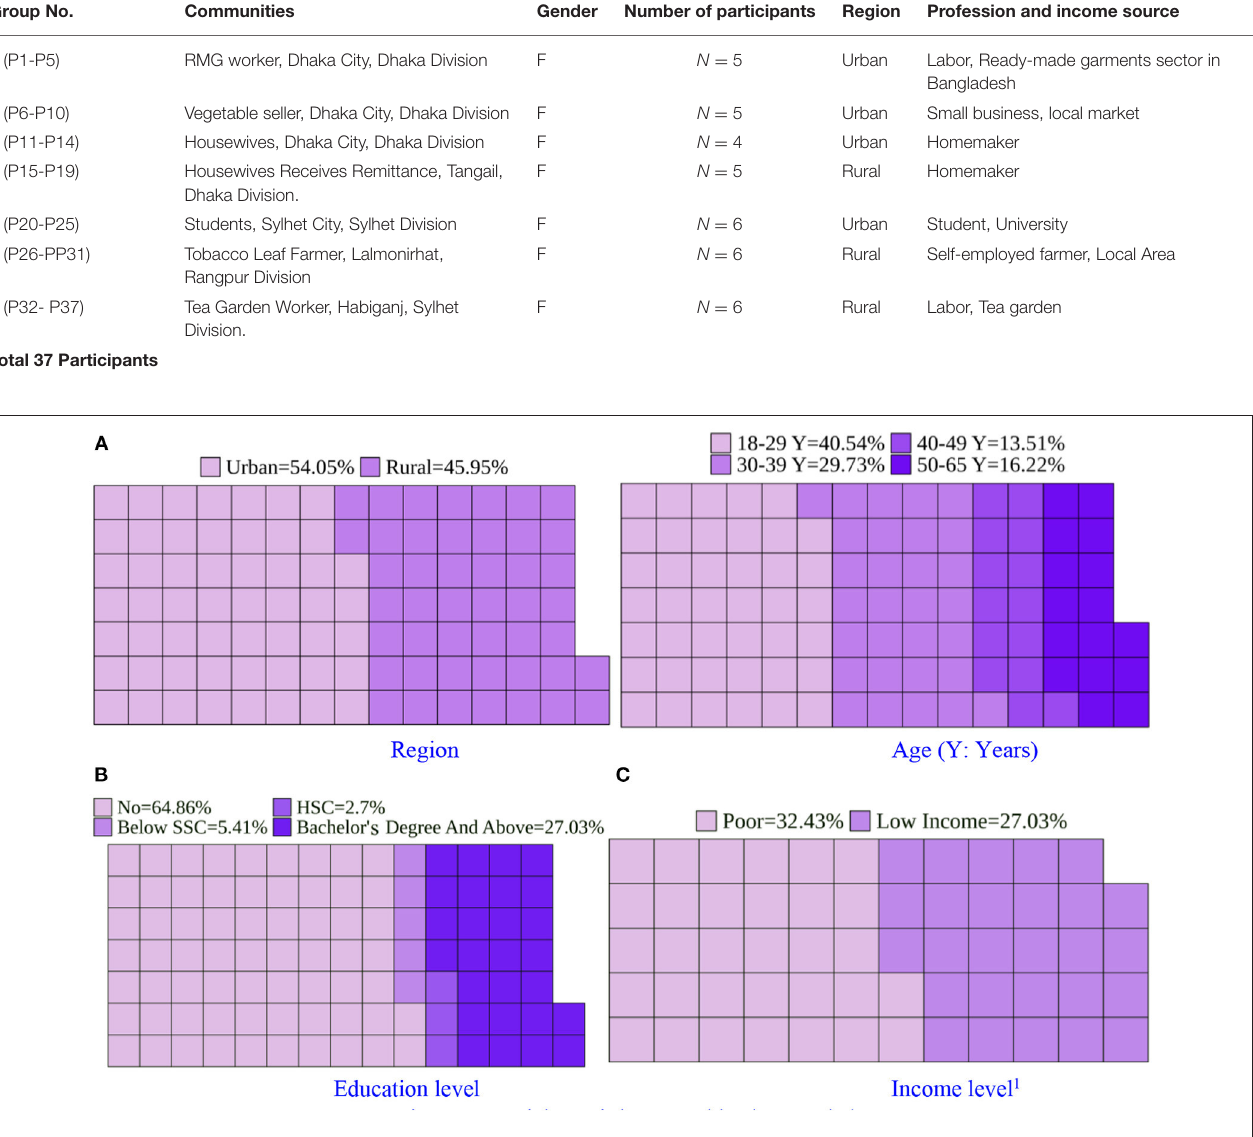
working in Singapore ate less to save money and shared that amount with his